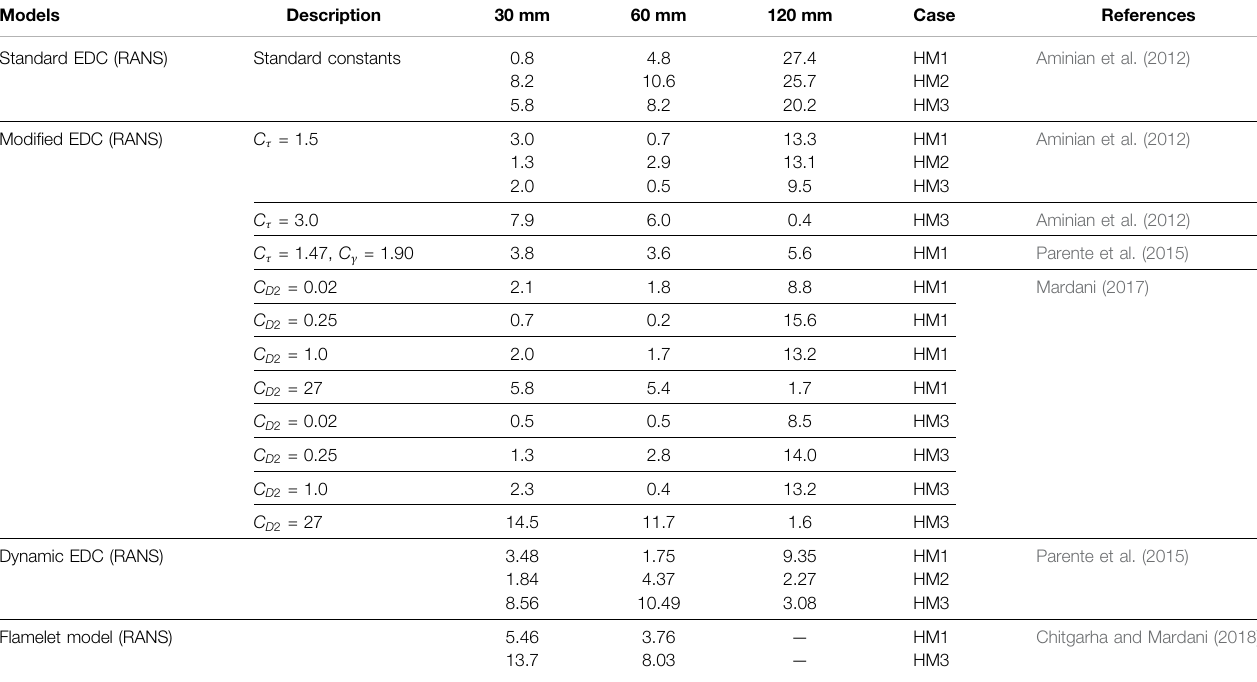
TABLE 2 | Absolute errors for temperature predictions (%) reported in literature with various combustion models